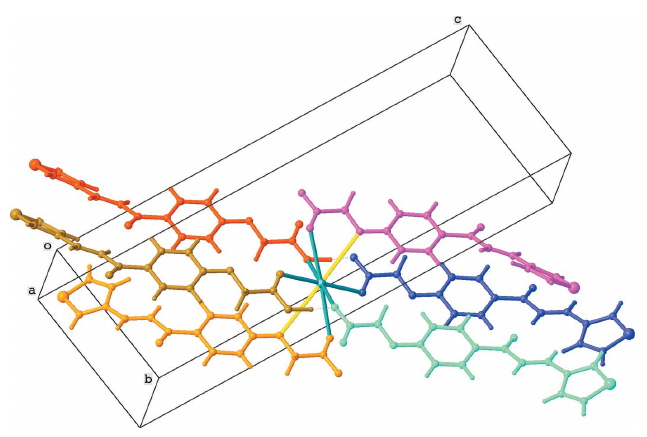
Figure 4 Potassium atom K41 is surrounded by six different molecules. The six K (cid:3)(cid:3)(cid:3) O interactions participating in the distorted octahedral coordination are shown in turquoise, the two longer ones in yellow.